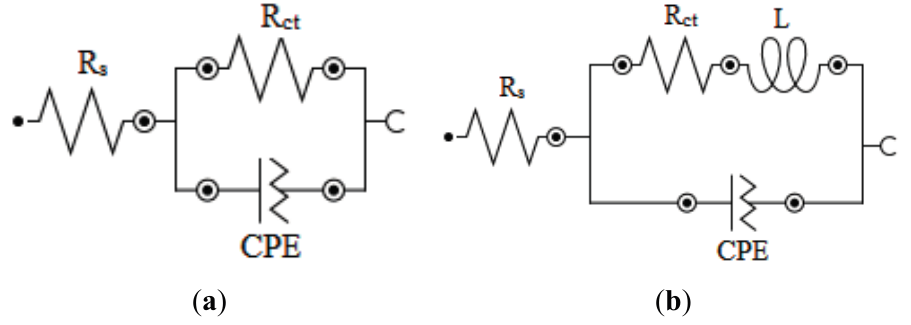
Figure 5. Equivalent circuits employed for the fitting of impedance spectra of N80 steel in 3.5% NaCl saturated with CO 2 ( a ) without the inhibitors ( b ) with